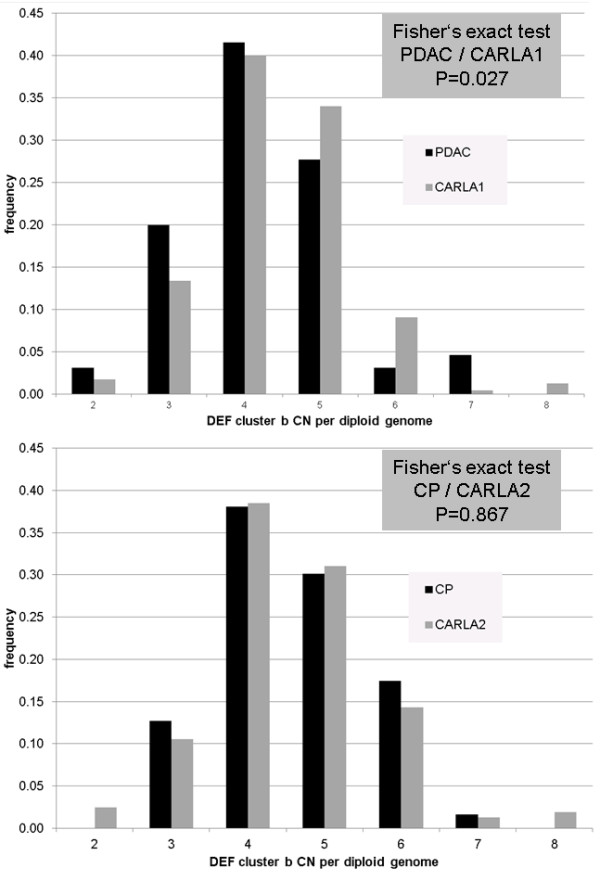
Distribution of DEF cluster b CN per diploid genome in the PDAC and CARLA1 (top) and CP and CARLA2 (bottom) cohorts.